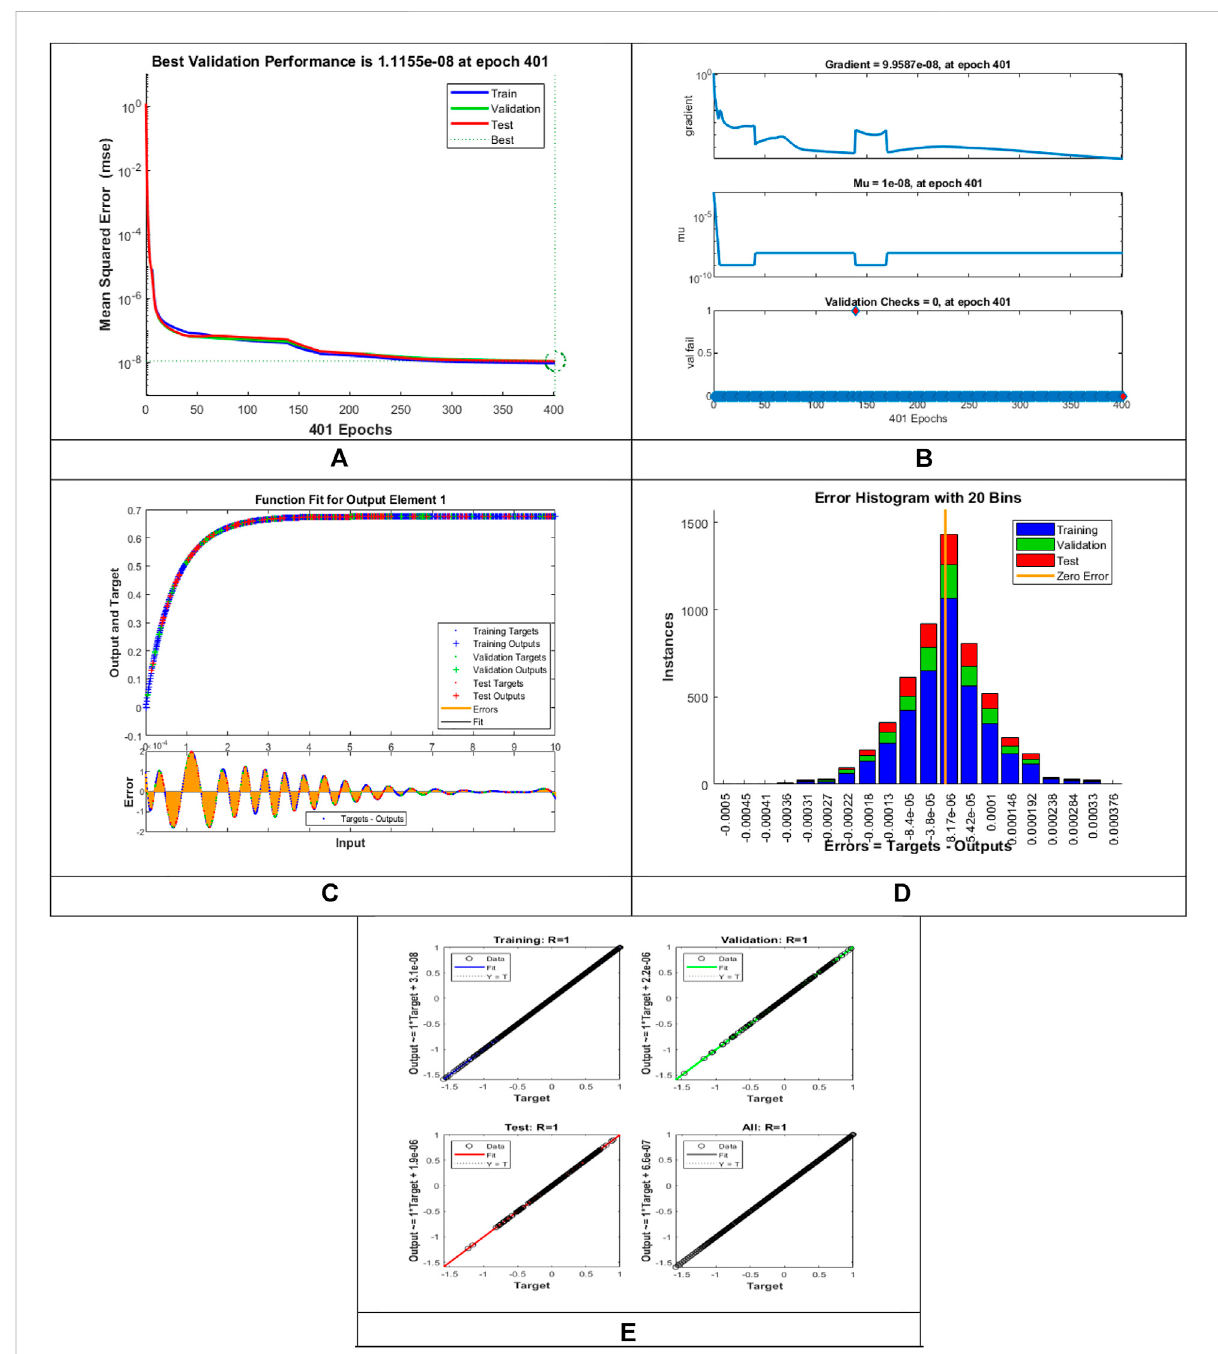
FIGURE 9 Pictorial illustration for the LMLA-BPNN base on variants of θ w vs θ ( η ) for MHD-WNF-HGA. (A) M-S-E demonstration, (B) transition state analysis, (C) curve fi tting, (D) error histogram, and (E) regression